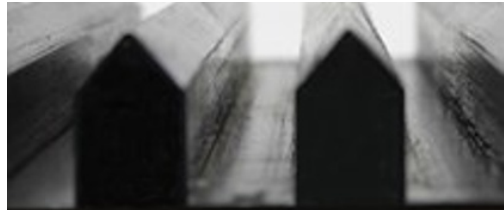
Fig. 3. Laboratory model of a pitched roof bidimensional urban canyon.